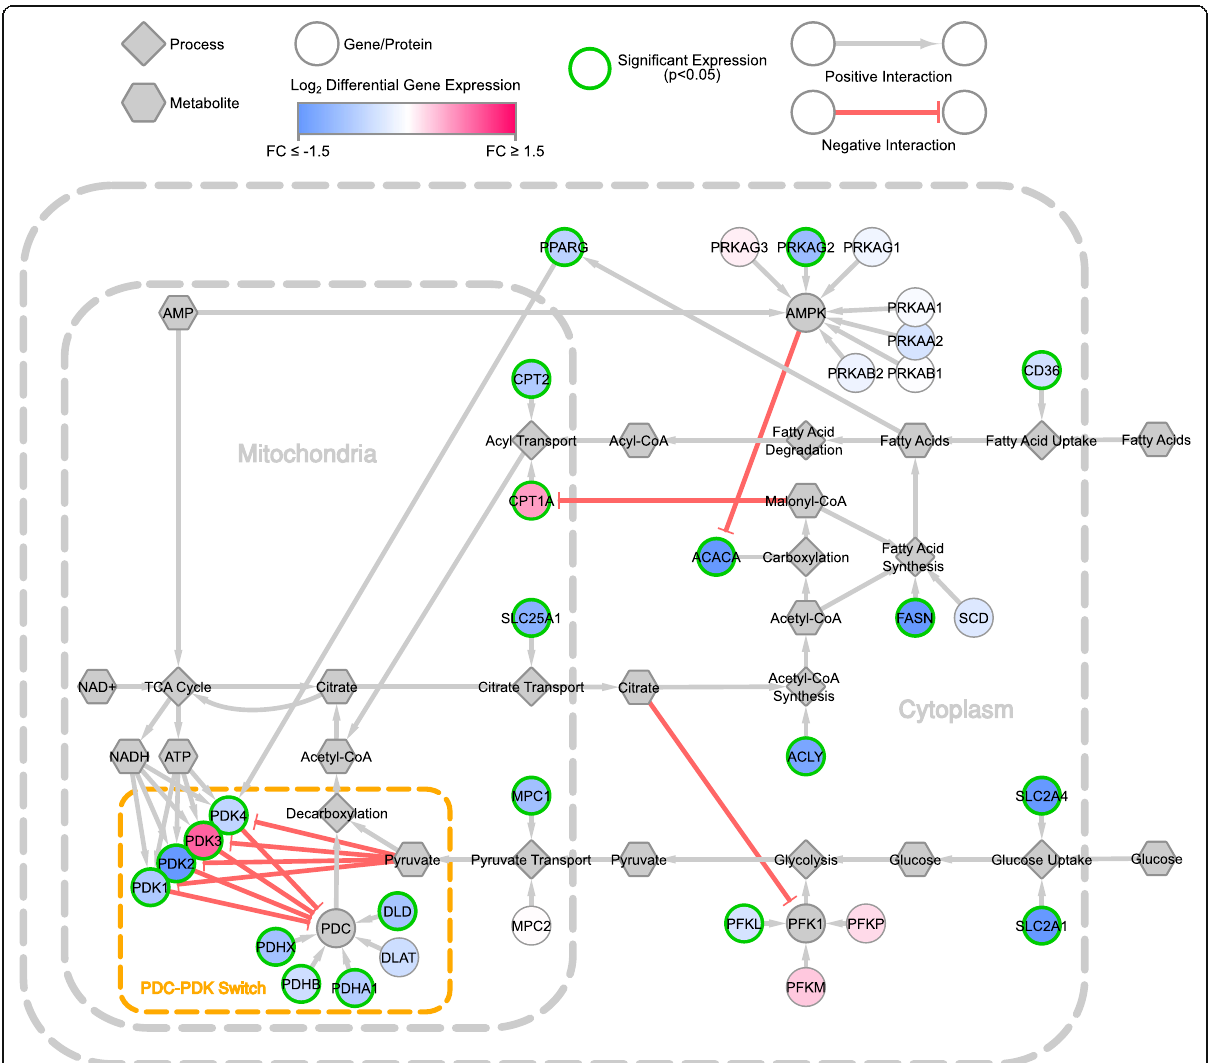
Fig. 4 Differential expression of the metabolic flexibility network between obese vs lean healthy individuals. Data shown is GSE55200 from the gene expression omnibus. FC means fold